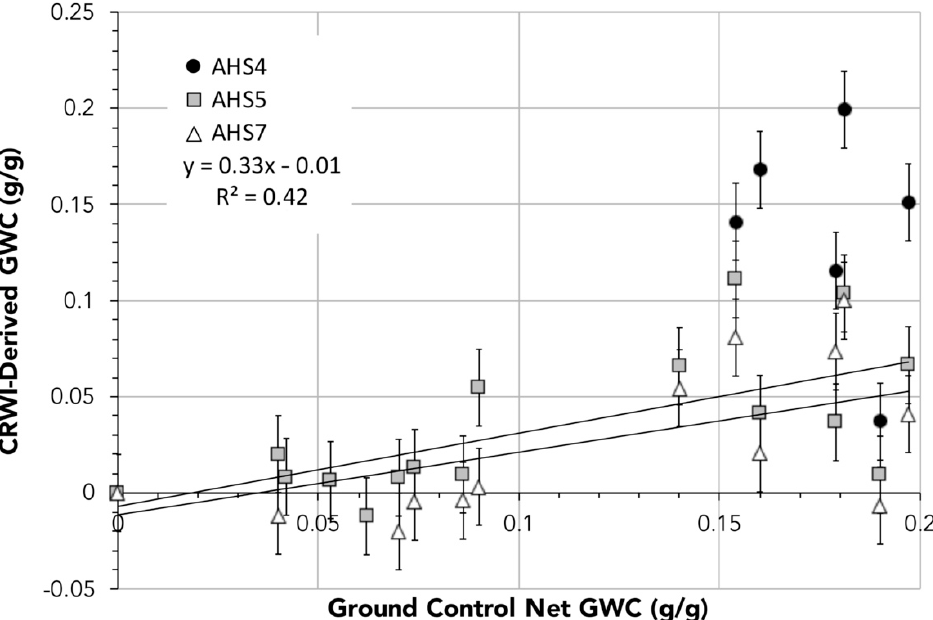
Figure 13. Ground control point net gravimetric water content (GWC) versus CRWI-derived GWC at the ground sampling points. Linear fit show is for AHS 7, R 2 = 0.42, p = 0.017. It is not possible to interpolate WISOIL-derived soil moisture measurements between airborne measurement points because WISOIL indices calculated using the airborne re- flectance measurements exceed 1 and therefore produce negative apparent soil moisture values. See discussion for analysis of possible reasons.